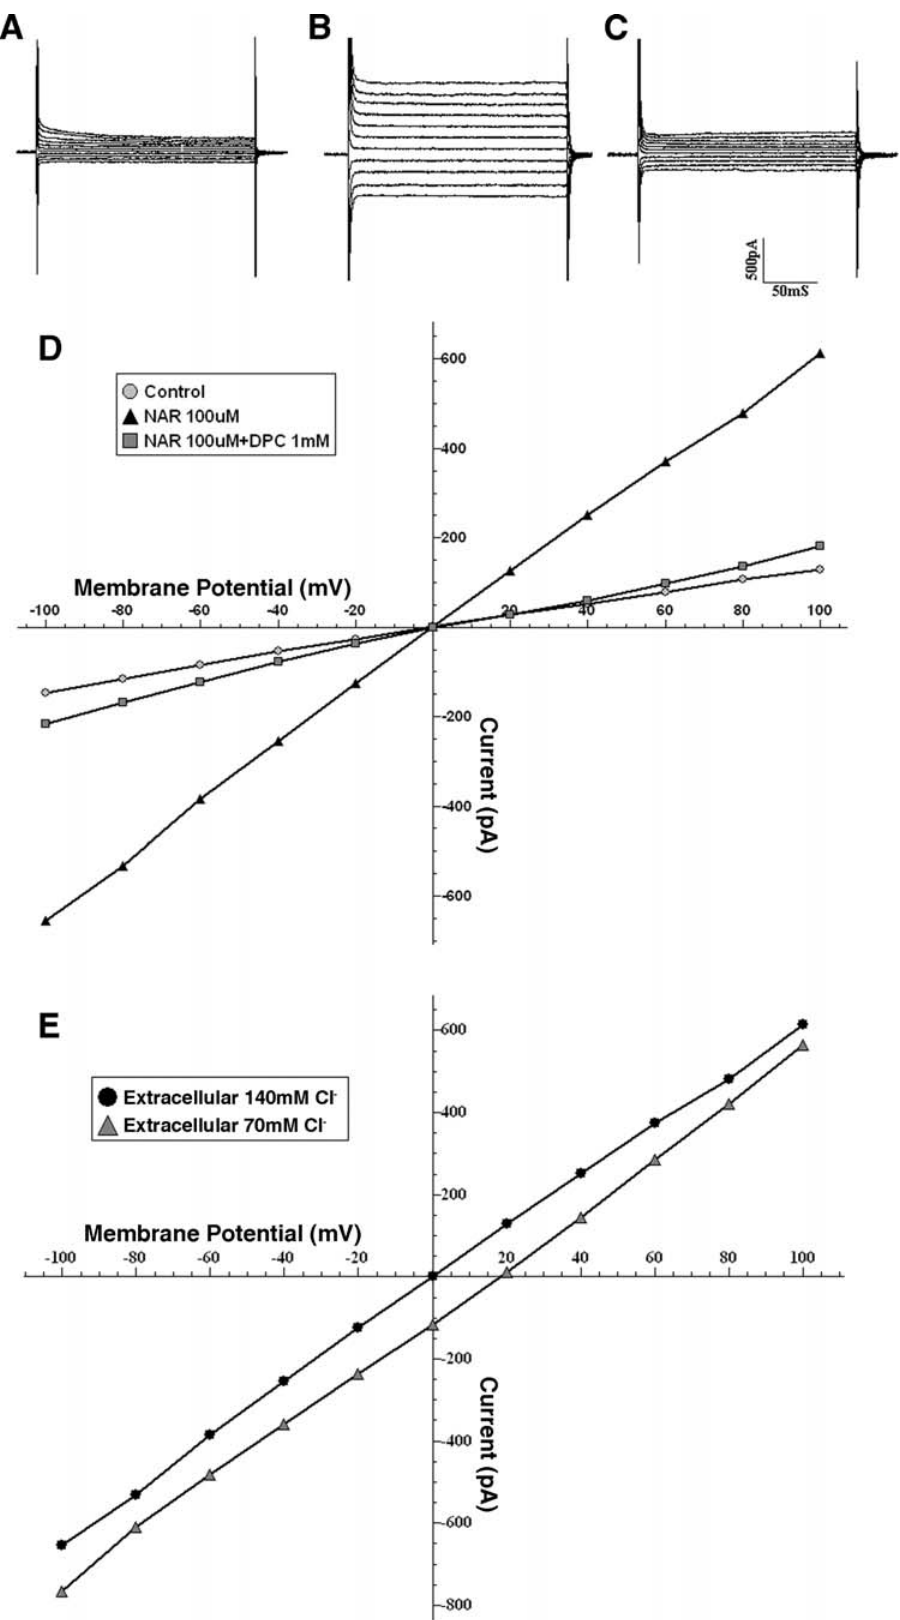
Figure 7. Characteristics of NAR-induced whole cell current in T84 cells. A, B, and C, typical whole cell currents recorded by holding the membrane potential at 2 30 mV and pulsing to voltages in a range of 6 80 mV in 20-mV steps from (A) a control cell; (B) a cell applied with NAR (100 m M) to the bath solution; (C) a cell pre-exposed to 100 m M NAR applied with 1 mM DPC; (D) corresponding current-voltage relationship obtained from currents in A, B and C; (E) Whole-cell recordings obtained after NAR stimulation from a cell bathed in 70 mM NMDGCl with corresponding I–V relationships. Note that reversal potential was shifted from 0 to 17.3 mV, close to the new E Cl =18.7 mV. doi:10.1371/journal.pone.0003348.g007 PLoS ONE |